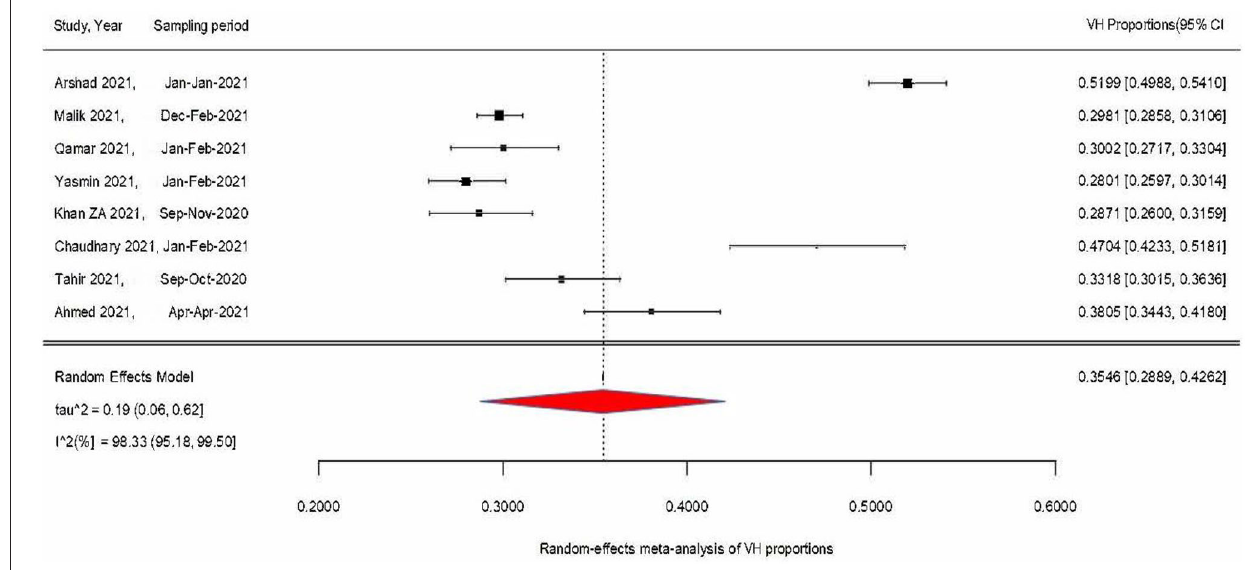
FIGURE 1 | Meta-analysis of vaccine hesitancy proportions (Jan 2020 to Oct 2021).